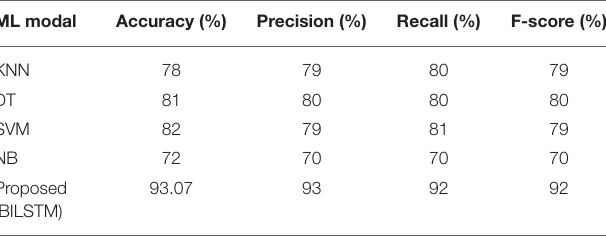
TABLE 5 | Machine learning classifiers vs. proposed model (BILSTM).